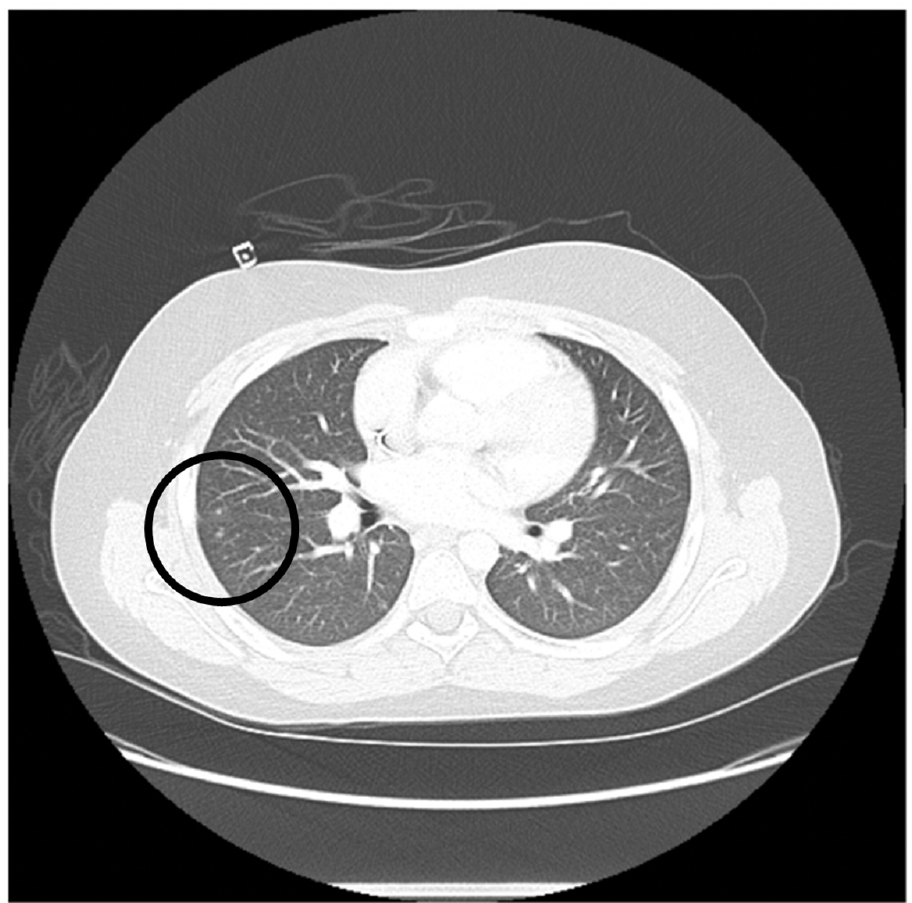
Figure 1. Computed tomography (CT) chest imaging of an 11-year-old patient with relapsed AML is shown. CT chest imaging with bilateral ground-glass opacities and pulmonary nodules (seen inside the black circle) consistent with pulmonary toxoplasmosis. The CT chest was performed 3 months prior to HSCT.